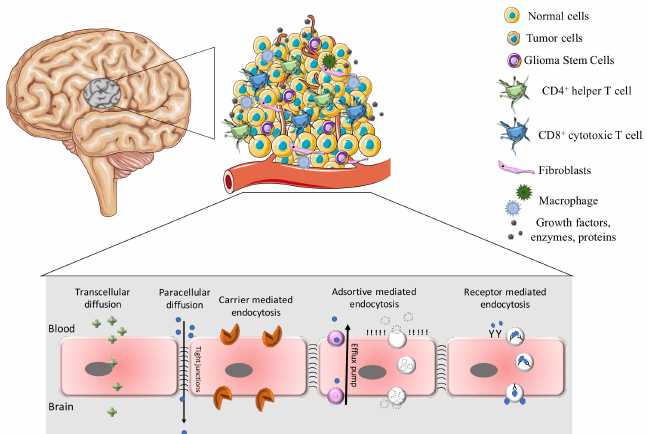
Brain tumor structure and therapeutic brain delivery strategies for targeting the physiological blood–brain barrier (BBB), including transcellular lipophilic diffusion, paracellular hydrophobic diffusion, carrier mediated endocytosis, ATP-binding cassette (ABC)-transporters, adsorptive mediated transcytosis and receptor mediated endocytosis. In addition, it is represented the tumor microenvironment with tumor cells, glioma stem cells, CD4 + helper T cells, CD8 + cytotoxic T cells, fibroblasts, macrophages, growth factors, enzymes and